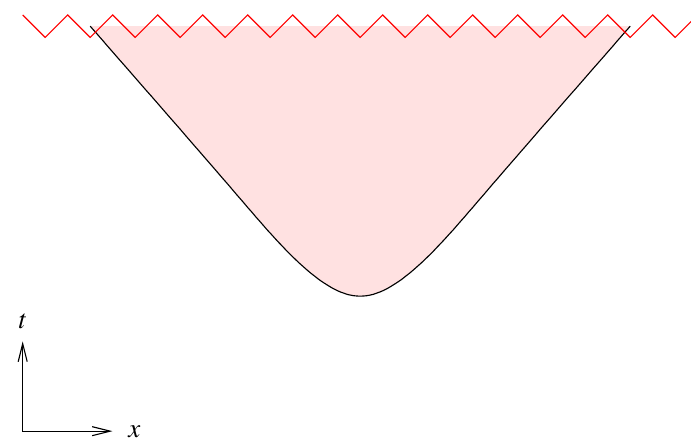
Figure 1. The red zigzag line marks the space-like singularity due to the time-like linear dilaton. This background admits an unconventional string solution — a closed folded string that is created classically at a certain point in